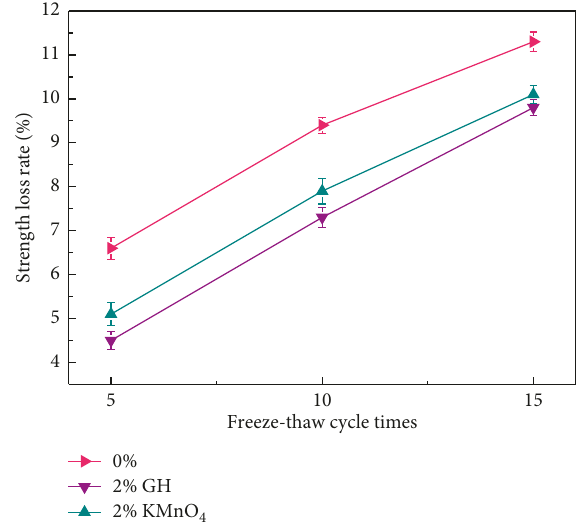
Figure 4: The strength loss rate of dredged sludge solidified body after freeze-thaw cycles.